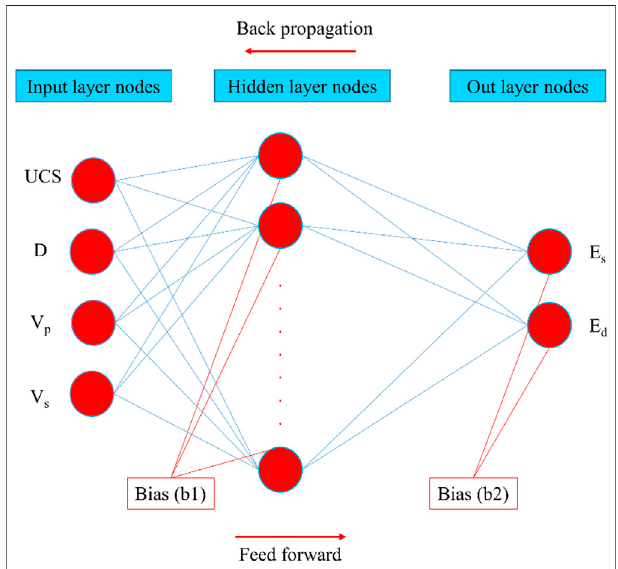
FIGURE 4 | Basic architecture of ANN